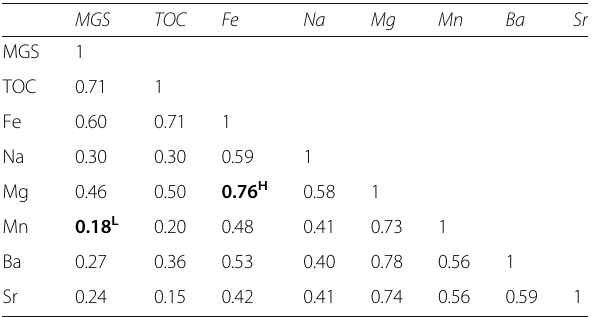
Table 2 Correlation coefficient between MGS, TOC, and selected metals in core KR1